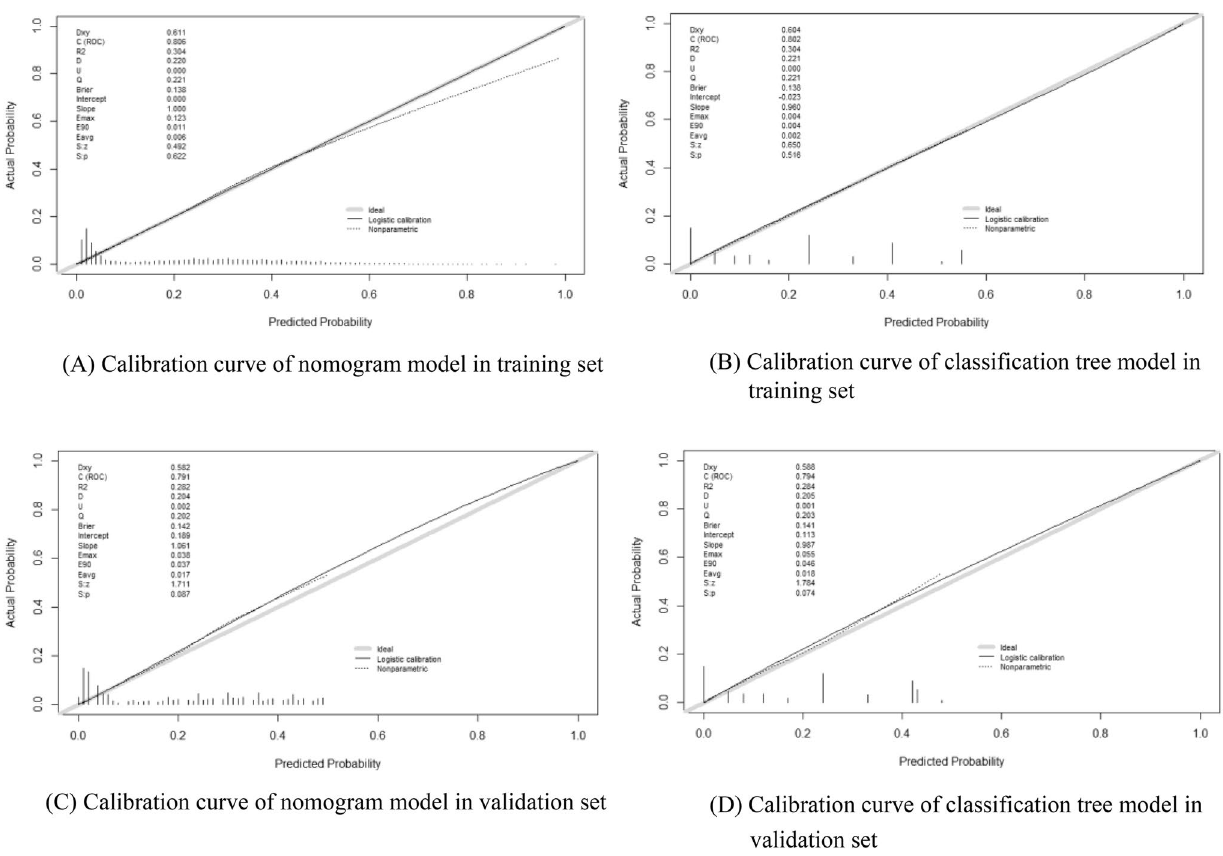
Figure 4. Calibration curves of the two models in the training and validation sets. The dashed line represents the predicted incidence curve, the black solid line represents the actual incidence curve and the gray line represents the ideal reference curve at 45°. P > 0.05 in the 4 graphs indicates that the difference between the predicted incidence curve and the actual incidence curve is not statistically significant. The figure was created by using R software (version 4.0.0), URL: https:// www.r- proje ct.